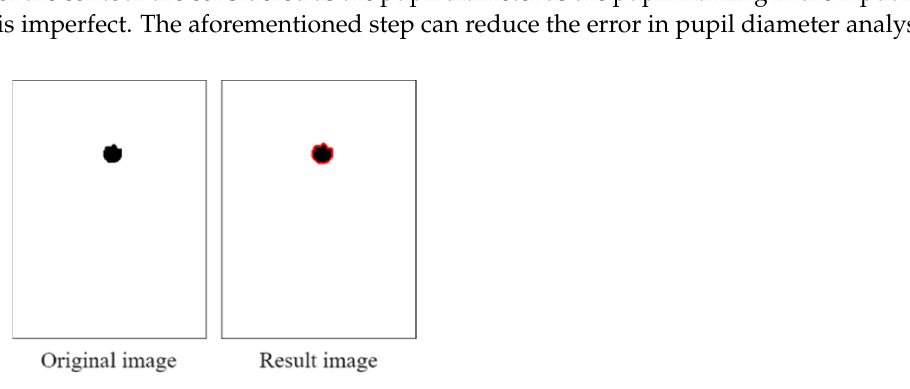
Figure 43. Results of the contour test obtained with the PRSSM-based pupil diameter analysis module.